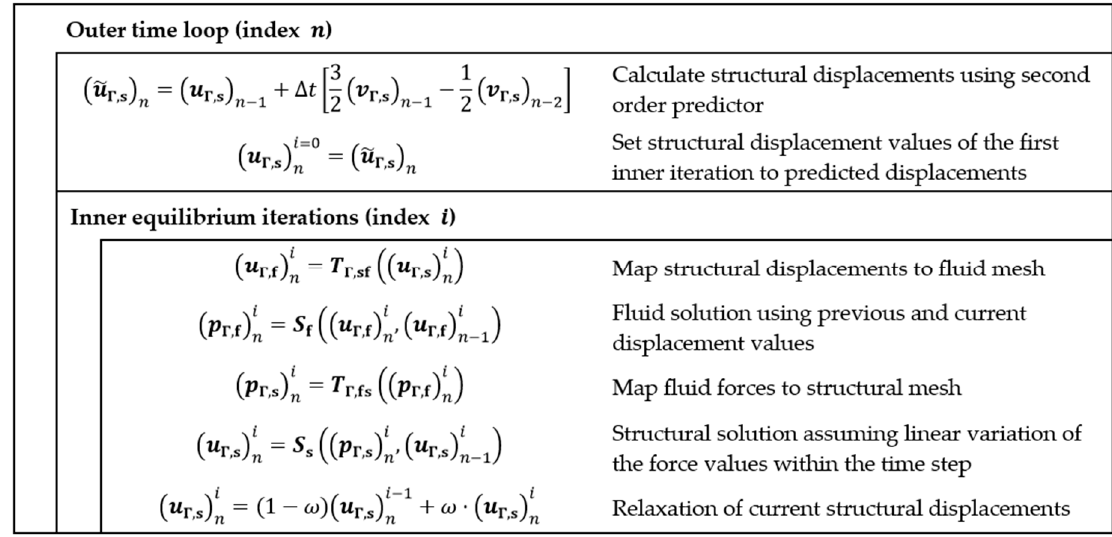
Figure 2. Solution procedure for time level 𝒕 𝒏 .